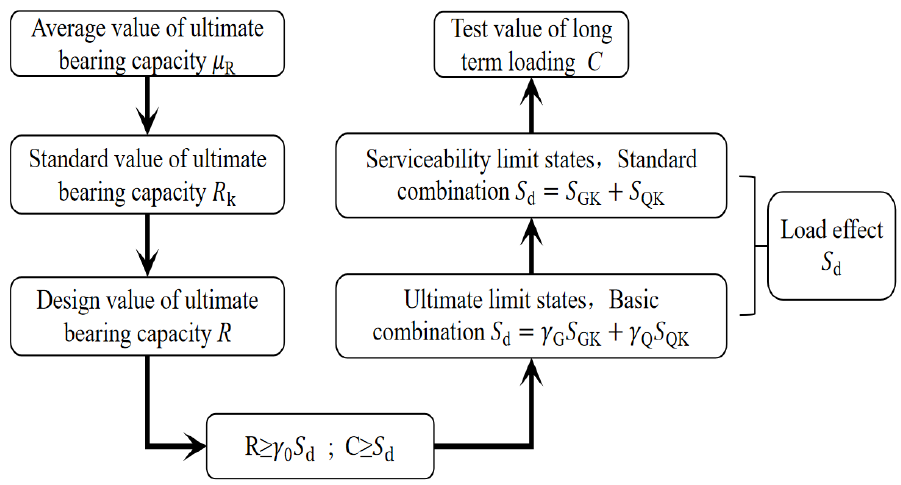
Figure 5. Derivation and determination of long-term loading value.